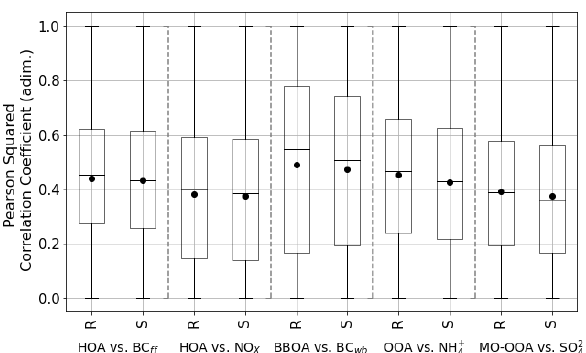
Figure 6. Rolling (R) and seasonal (S) boxplots of the Pearson squared correlation coefficient of each OA source with its respec- tive markers for all sites.